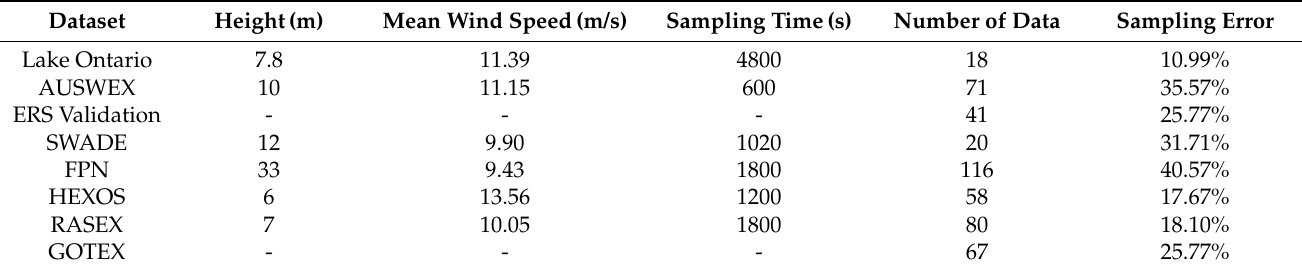
Table 3. Sampling errors of eight datasets.